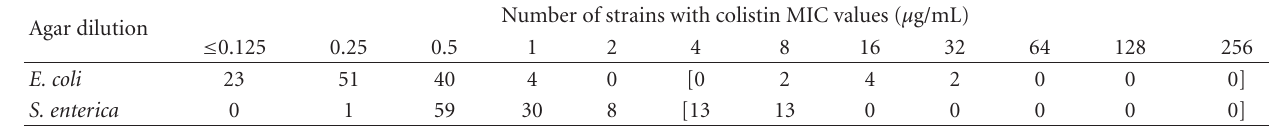
Table 1: Distribution of MIC values of swine E. coli and S. enterica strains through agar dilution test against colistin. Agar dilution